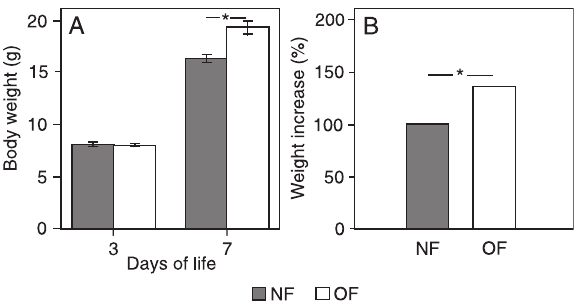
Figure 1. A , Body weight gain from the 3rd to the 7th day of post- natal life of normally fed (NF) and overfed (OF) rats. B , Percent of increase in the weight between the 3rd and 7th day of life for each group. Data are reported as means ± SEM. *P < 0.001 ( t- test for paired data in A, and for independent samples in